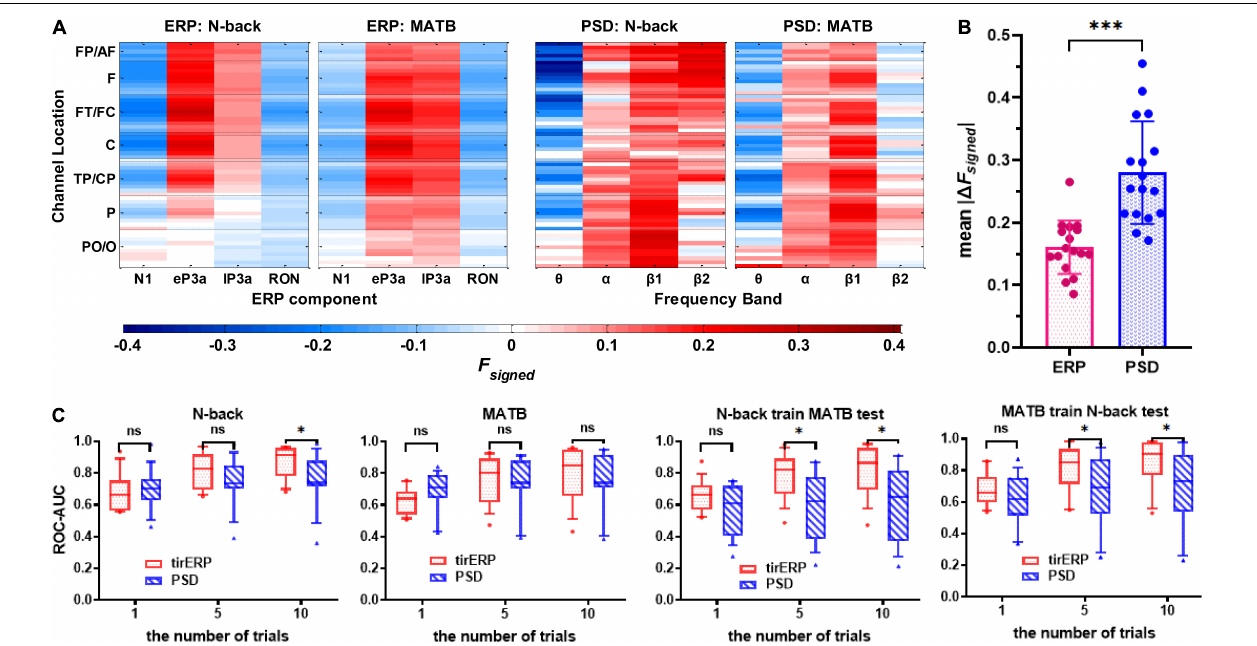
FIGURE 5 | (A) Grand average F signed for each feature of event-related potential (ERP) and power spectral density (PSD). (B) Mean values of (cid:12) (cid:12) (cid:49) F signed (cid:12) (cid:12) which were averaged across all features separately for ERP and PSD of each subject. (C) Performance (ROC-AUC) for within-task and cross-task classifications separately using PSD and tirERP features. The hashtags and asterisks in the figure indicate the significance level of the paired t -tests. ns, no significance; ∗ p FDR < 0.05; ∗∗∗ p 0.001.